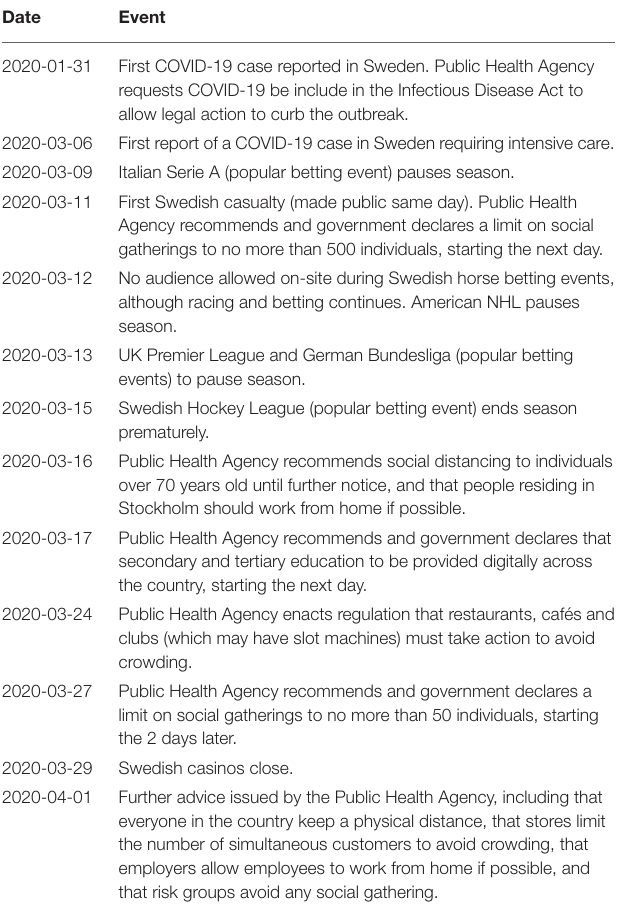
TABLE 1 | Non-exclusive timeline of domestic and international events with a possible direct or indirect effect on gambling activity in